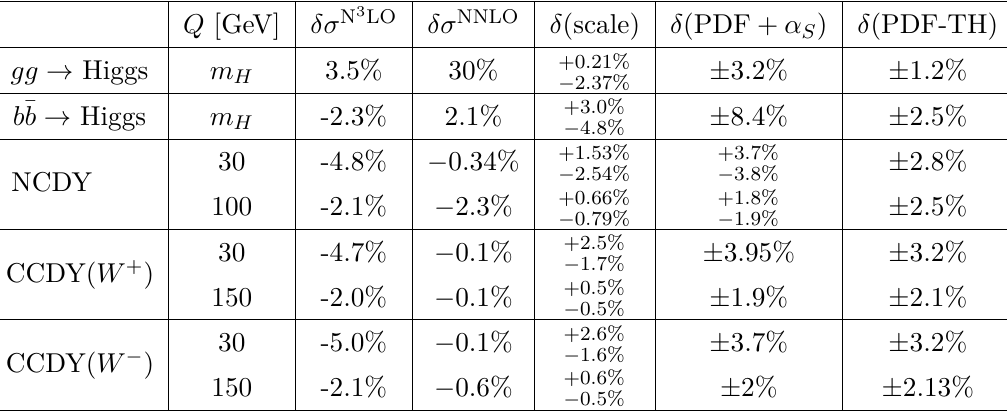
Table 5 . Results for production processes obtained with n3loxs . For details, see the discussion in the main